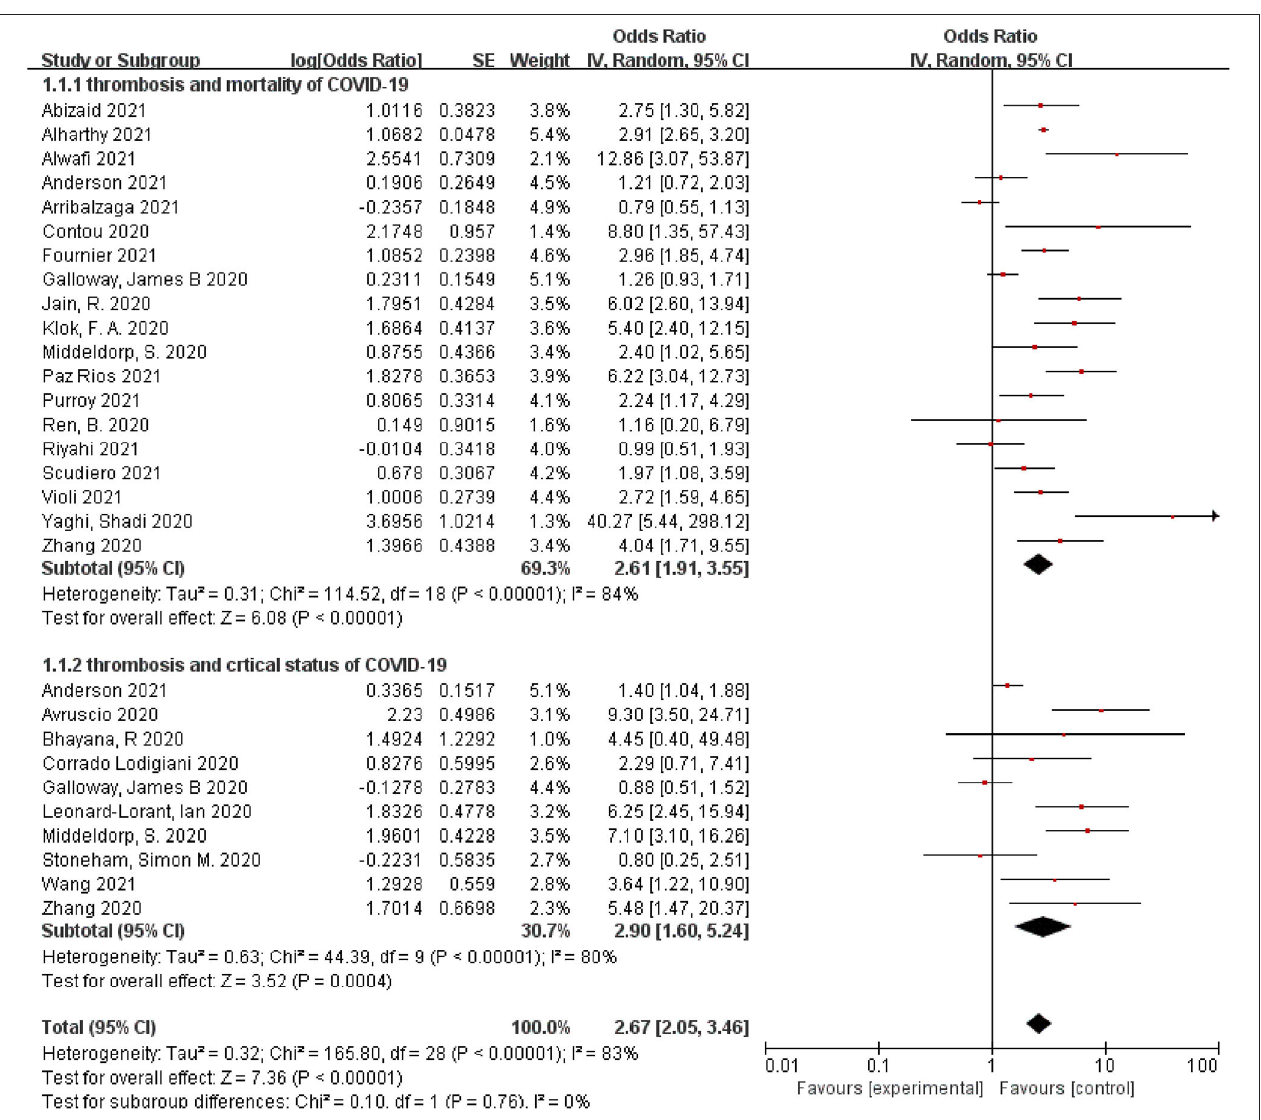
FIGURE 2 | A forest plot of the pooled odds ratio of the association between thrombosis and prognosis of COVID-19, including mortality and critical status.